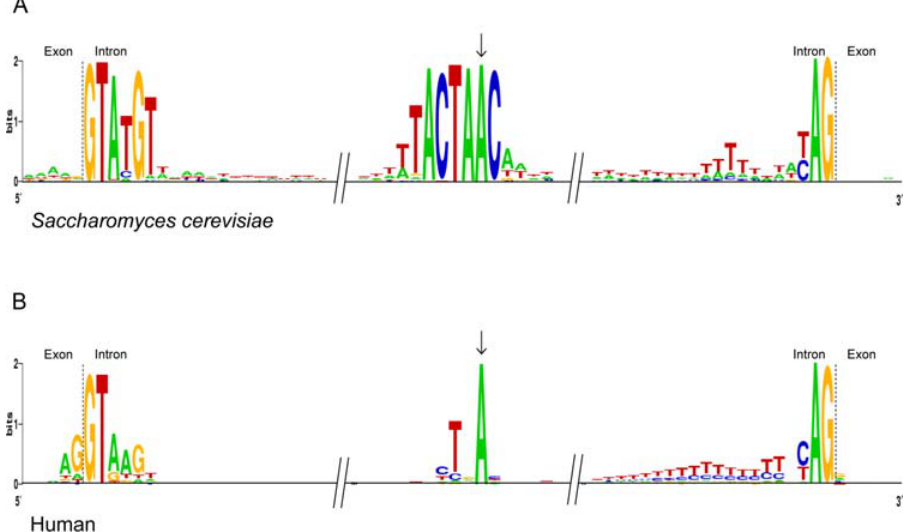
Figure 1. Intron sequence structures. Examples of a species with (A) strong consensus structures ( S. cerevisiae ), and (B) weakly conserved structures (human).